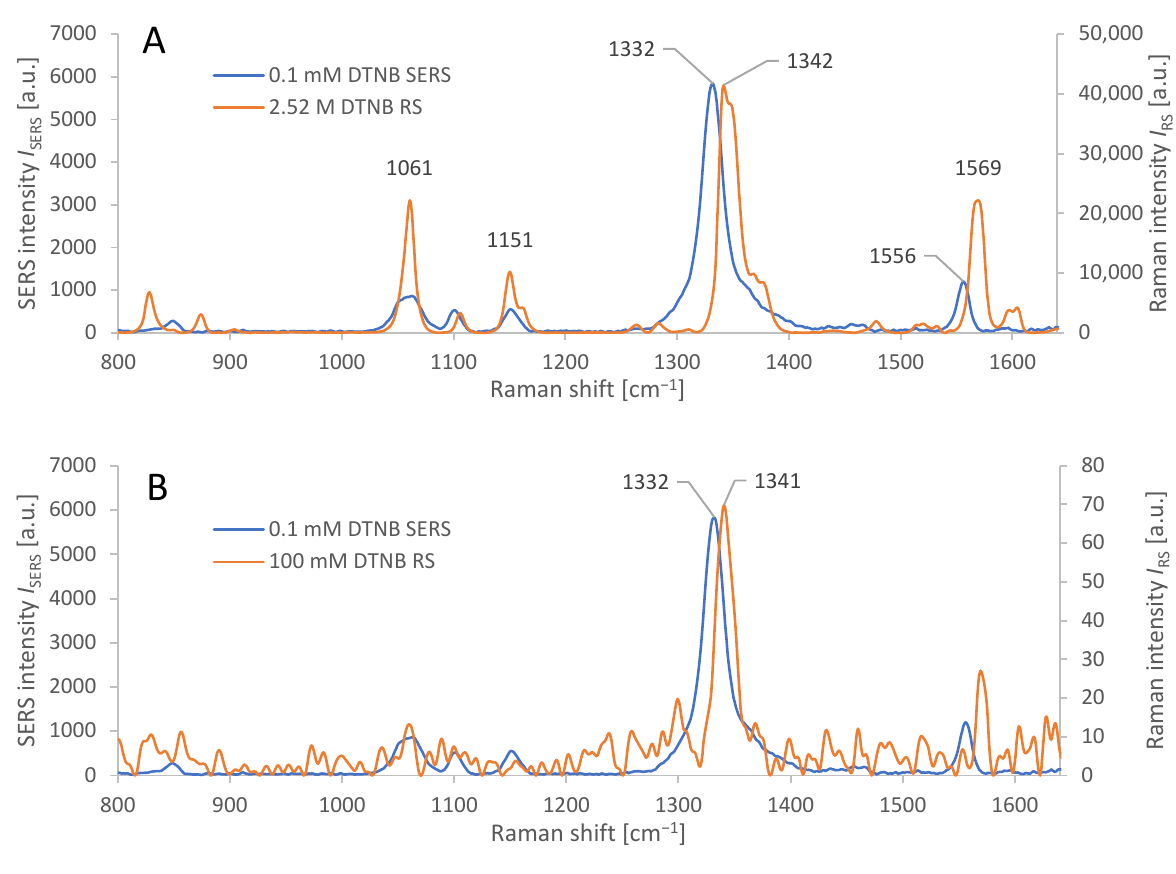
Figure 3. ( A ): Characteristic spectral response from AuNR-based SERS of adsorbed DTNB, applied in concentration 0.1 mM, compared to Raman spectroscopy of pure solid DTNB (2.52 M). Average spectra from 6 measurements each for SERS and RS. Absolute values of the spectral response were measured at identical laser power and integration time. ( B ) : Characteristic spectral response from AuNR based SERS of adsorbed DTNB, applied in concentration 0.1 mM, compared to Raman spectroscopy of a thin layer of DTNB on CaF 2 , from 100 mM solution, cf. Section 3.1. Average spectra from 6 measure- ments (SERS) and 15 measurements (RS). Microscope objective: 20 × ; for measurement parameters, see Section